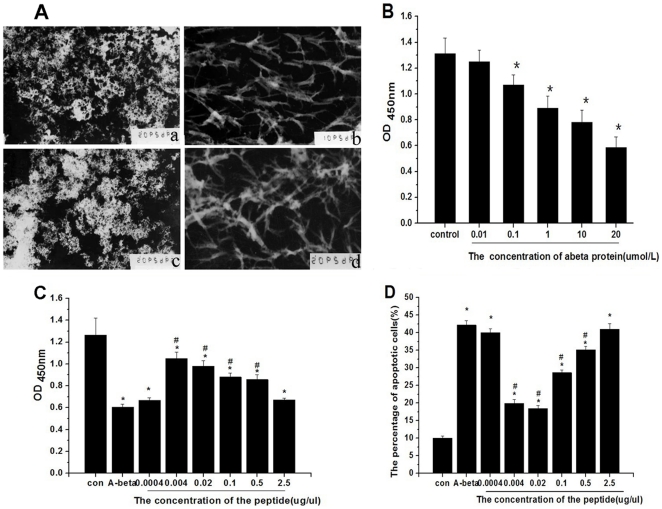
The special peptide alleviates Aβ aggregation and toxic effects in vitro.(A) Electron microscopic analysis of morphological change showing the effect of the special peptide or selected phage on Aβ1-42 aggregation. Aβ1-42 (a) or Aβ1-10 (c) alone was incubated for 7 days; Aβ1-42 with special peptide (b) or the selected phage (d) was incubated for 7 days; (B) Different concentrations of aggregated Aβ1-42 were tested to assess its effect on neuronal cell viability by CCK-8 assay. *P<0.05 when compared with the control group; (C) Cell viability was assessed in the presence of 20 µM Aβ1-42 and different concentrations of the special peptide by CCK-8 assay. *P<0.05 when compared with the control group. #
P<0.05 when compared with the group treated with 20 µM Aβ1-42 only (note: 0.04 µg/µl peptide equal to 20 µM); (D) Detection of apoptosis in PC12 cells by PI staining. *P<0.01 when compared with the control group. #P<0.01 when compared with the group treated with 20 µM Aβ1-42 only.